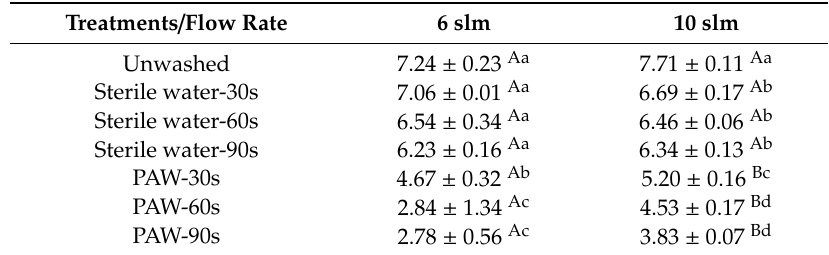
Table 3. The populations of Salmonella Enteritidis (log CFU / egg) on eggs treated in 1000 mL plasma-activated water (PAW) generated with two jets at 6 slm or 10